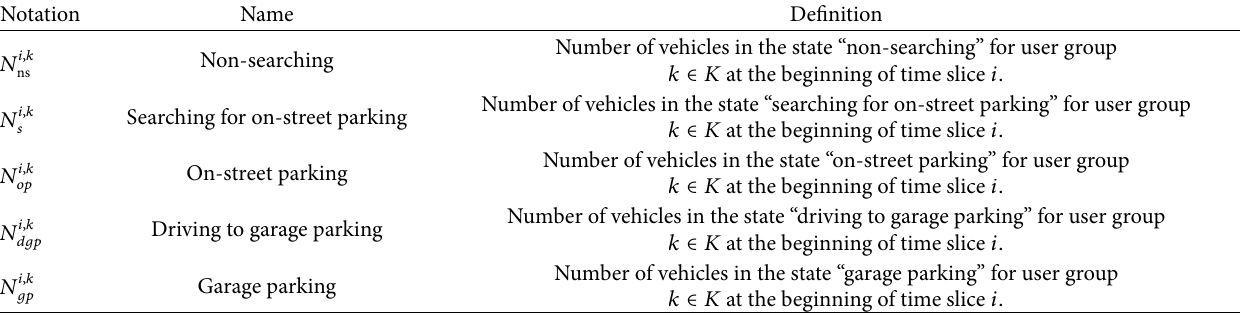
Table 5: All traffic state variables for the on-street and garage parking-state-based matrix per time